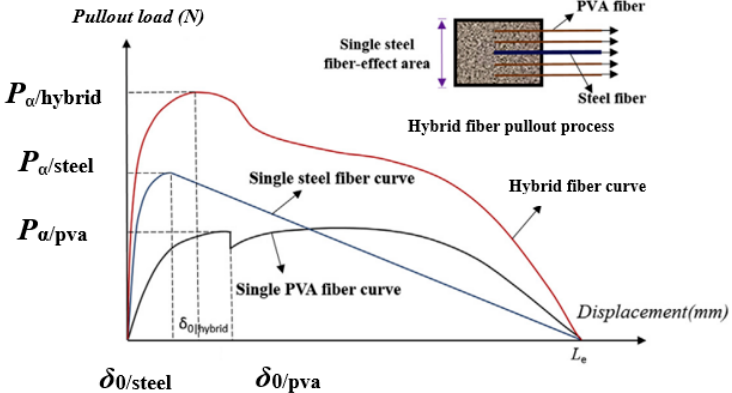
Figure 21. Load–displacement curve for the pullout of a single fiber [100].